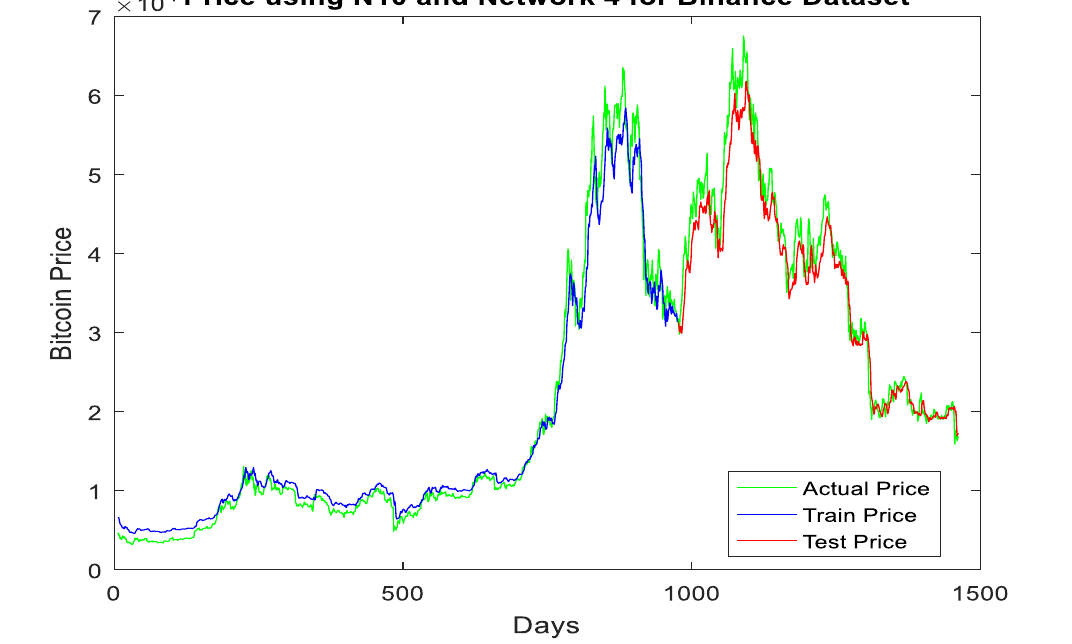
Figure 7. Training, testing and actual Bitcoin price of trignometric functions-based neural network model using proposed dual normalized Binance dataset.